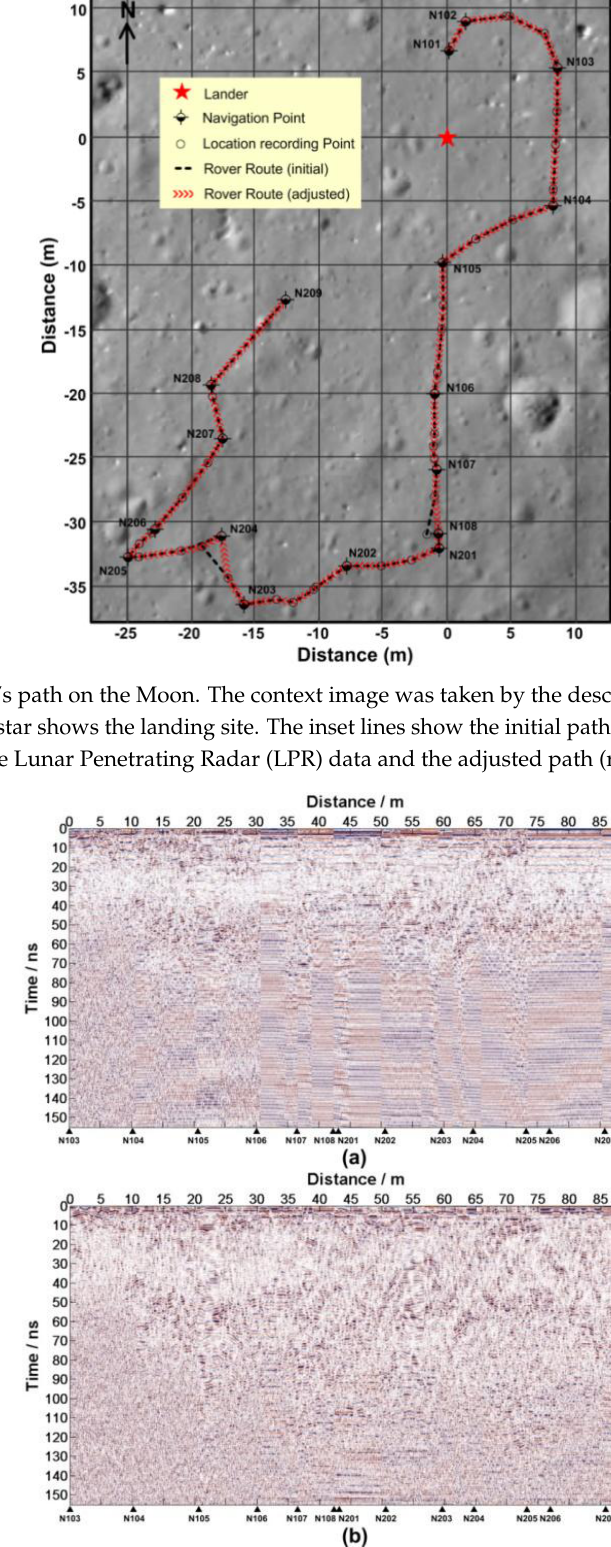
Figure 13. ( a ) Reflected waves caused by basalt blocksshown in CH-2A data and ( b ) Reflected waves caused by basalt blocksshown in CH-2B data.